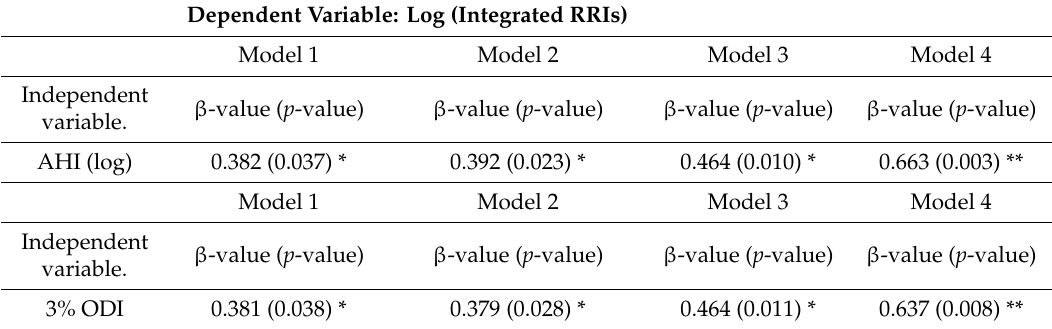
Table 4. Multiple linear regression analysis of the integrated RRIs and AHI or 3% oxygen desaturation index (ODI). Dependent Variable: Log (Integrated RRIs) Model 1 Model 2 Model 3 Model